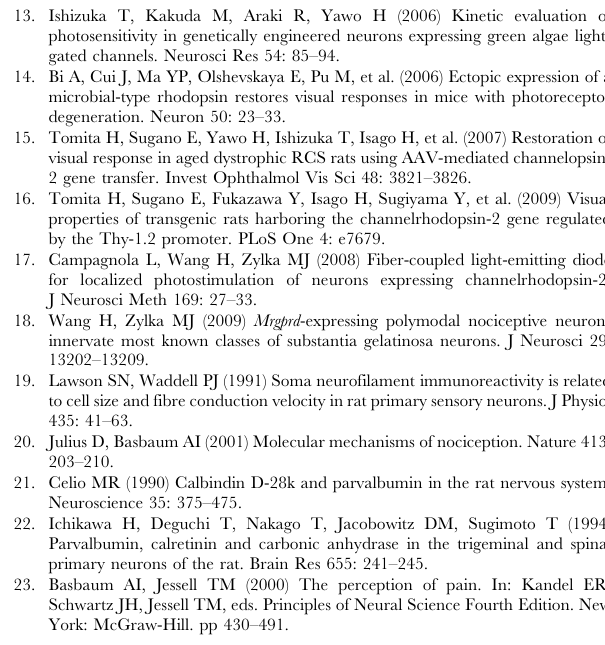
Figure S1 Expression of ChR2V in the brain of W- TChR2V4 rat. Figure S2 Expression of ChR2V in the spinal cord and the motor nerve terminals. Figure S3 Non-fluorescent DRG neurons were unre- sponsive to the blue light. Figure S4 The primers that were used to differentiate ChR2V + from ChR2V 2 rats. Figure S5 Expression of ChR2V in the tail nerve